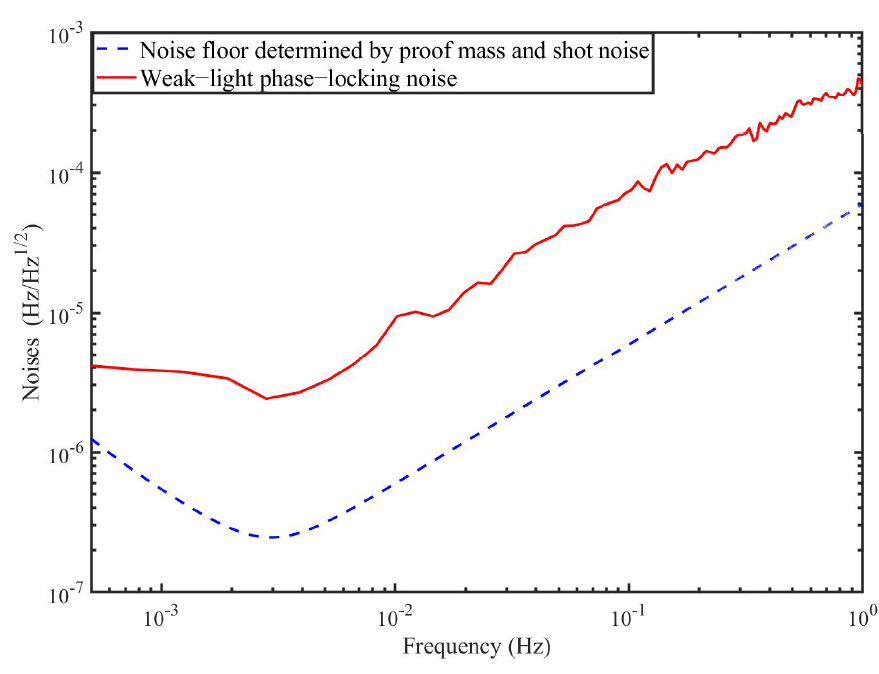
Figure 5. A measurement of the WLPL noise (solid trace), and the sensitivity of the GW detection (dashed